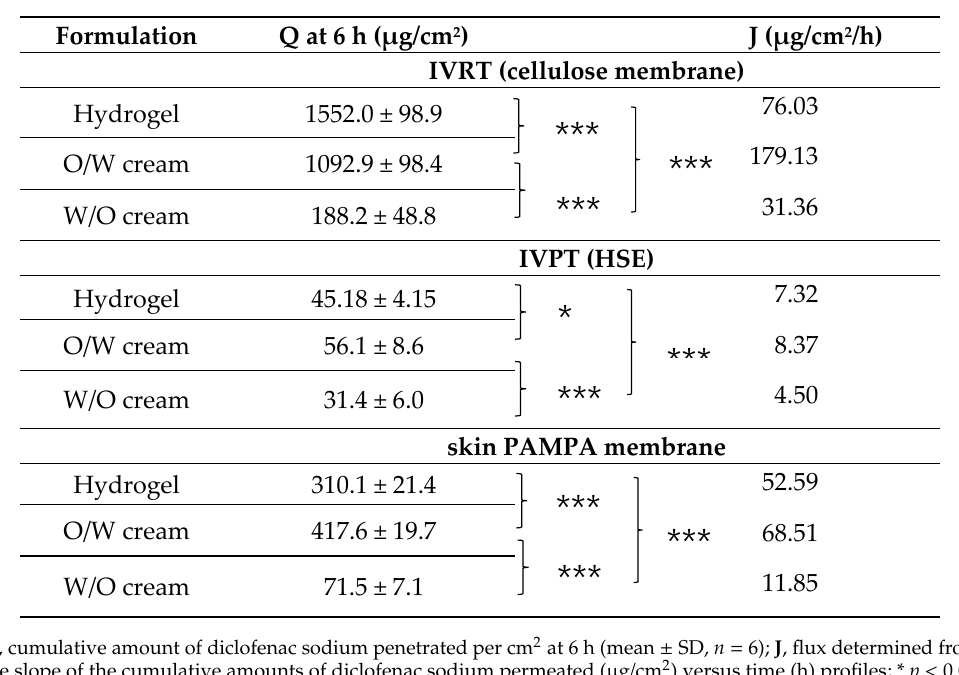
Table 1. Permeation parameters of diclofenac sodium through cellulose membrane, heat-separated human epidermis and skin parallel artificial membrane permeability assay (PAMPA) membrane after 6 h.